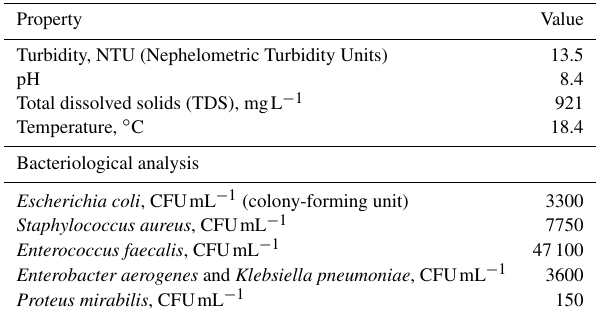
Table 1. Characteristics of raw water